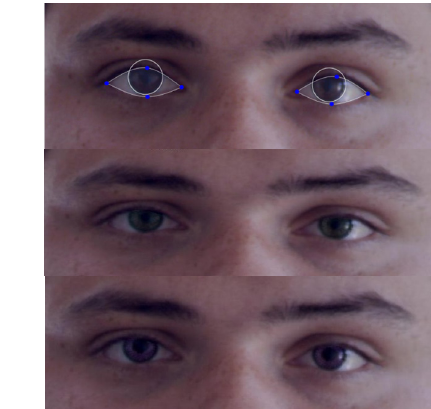
Figure 24. Demonstrator application—virtual contact lens simulator. On the first row: detection: detection result (iris circle and sclera segmentation). On the next two rows: different contact lens simulations: natural green, dark green, ocean blue, and violet.